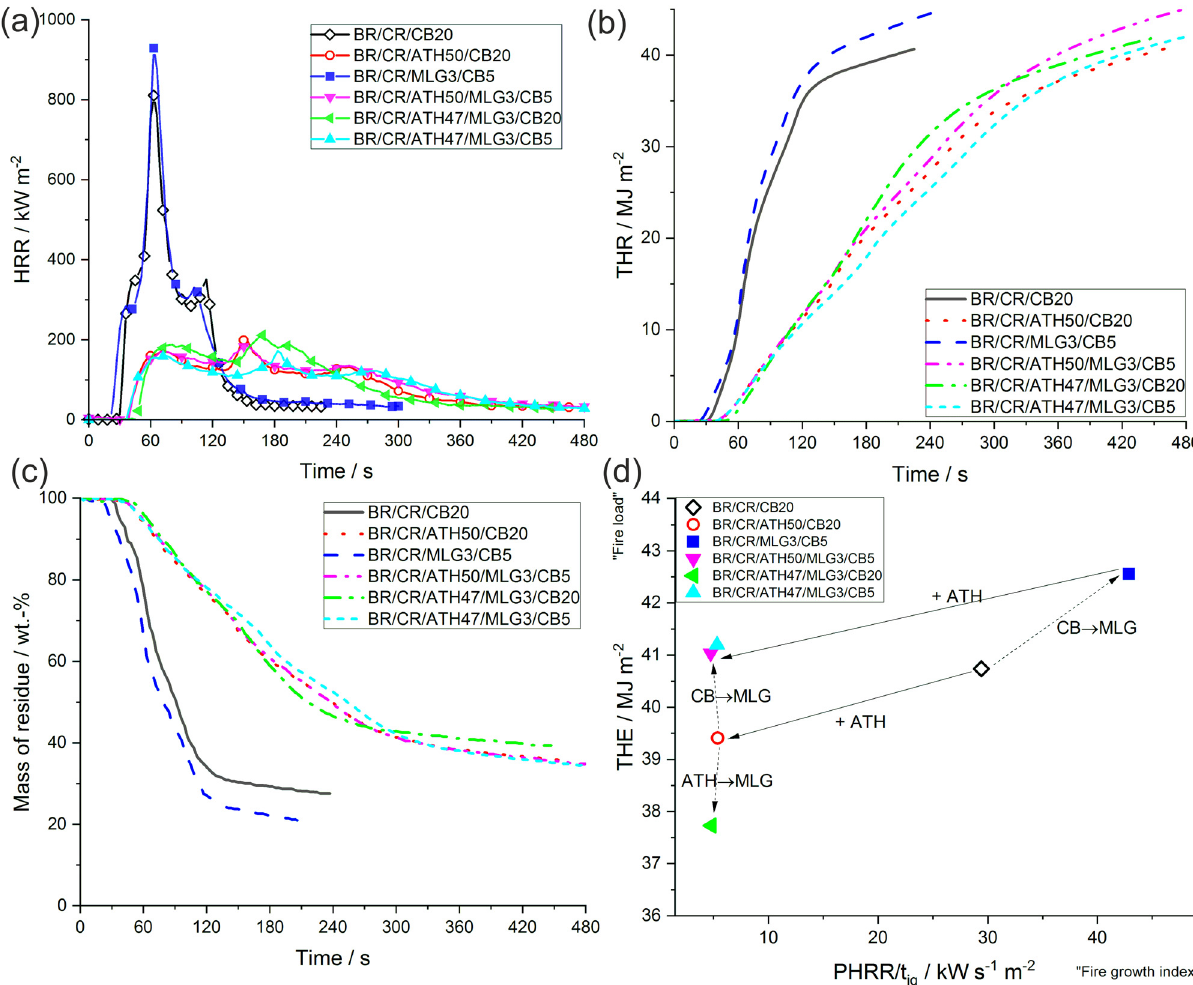
Figure 11: ( a ) HRR, ( b ) THR, ( c ) mass of residue, and ( d ) THE of the BR/CR composites as a function of time.